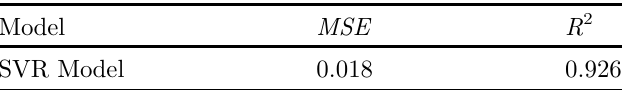
Table 1. The MSE and R 2 values of the SVR model on training set.